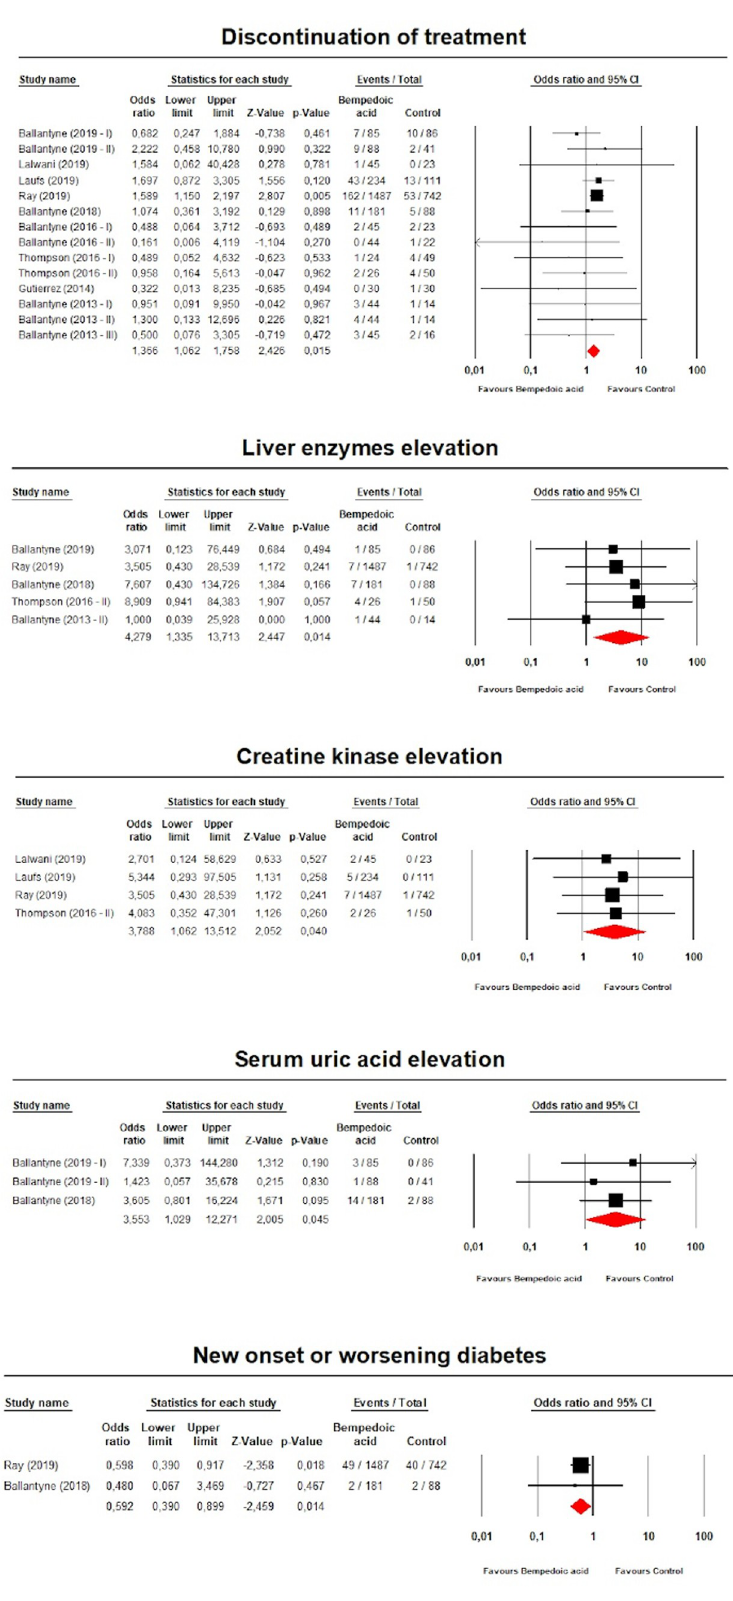
Fig 13. Forest plot comparing the risk of adverse events statistically associated with bempedoic acid treatment.